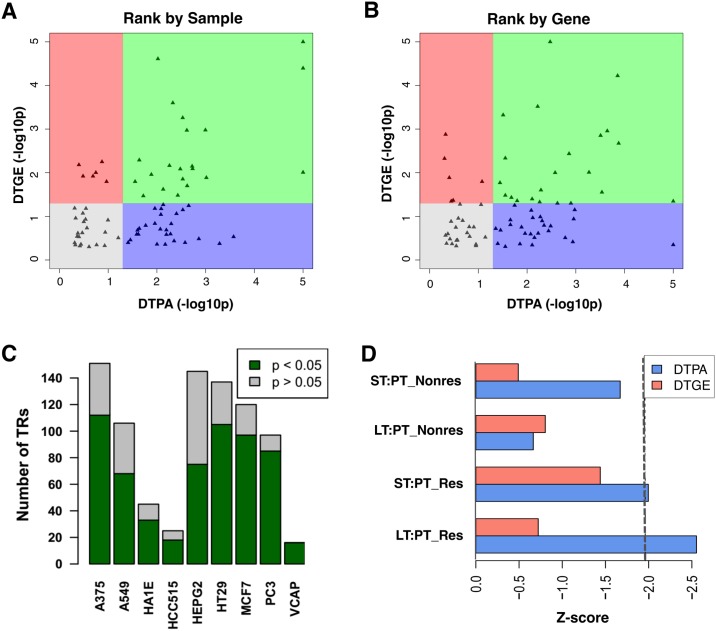
CMAP and LINCS dataset analysis.(A—B) Analysis for drugs targeting 75 TRs using either DTPA or DTGE for CMAP MCF7 datasets. For each TR with known inhibitors in the MCF7 dataset, we performed gene set enrichment analysis to test whether its DTPA or DTGE for its known inhibitors are significantly more inactivated or repressed compared to all other compound’s profiles (A) or to all other proteins (B) and obtained p-values from each test. Then we plotted the distributions of the–log10 p-values for DTPA (x-axis) versus DTGE (y-axis). Each triangle represents a TR. A vertical and a horizontal line were drawn at p-value equals 0.05 for DTPA and DTGE, respectively, which divide the plot into four parts: green, blue, red, and grey. (C) Enrichment analysis of the drug samples similar to TR silencing profiles on the vector of all drug samples in the same cell line sorted based on their inferred TR activity from LINCS data set. Each bar represents a cell line. Green color shows the number of TRs with significant enrichment (NES > 1.96; p < 0.05) which indicates the correlation between OncoLead CMoA inference and shRNA mediated TR silencing. Grey color shows the number of TRs without significant enrichment (NES< 1.96; p > 0.05). (D) OncoLead-inferred ESR1 activity changes (blue) and the differential ESR1 expression (red) upon letrozole treatment in vivo. Signatures are obtained by comparing different time points in responsive and non-responsive patients. The values shown in the figures are Z-scores based on p-value. The black dotted line represents Z-score = 1.96 and p-value = 0.05.